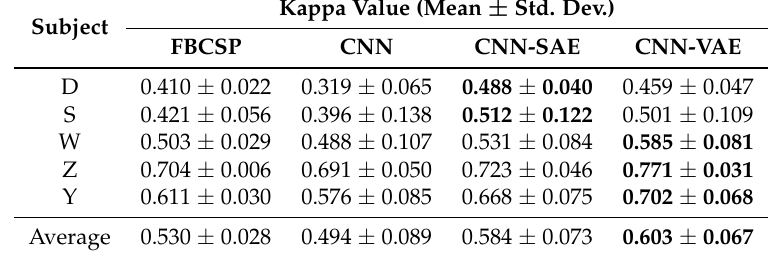
Table 4. Comparison of kappa value and standard deviation for CNN-VAE and 3 Competitive Methods our own dataset with 5 electrodes. (The data in bold is the best performance among the different methods).